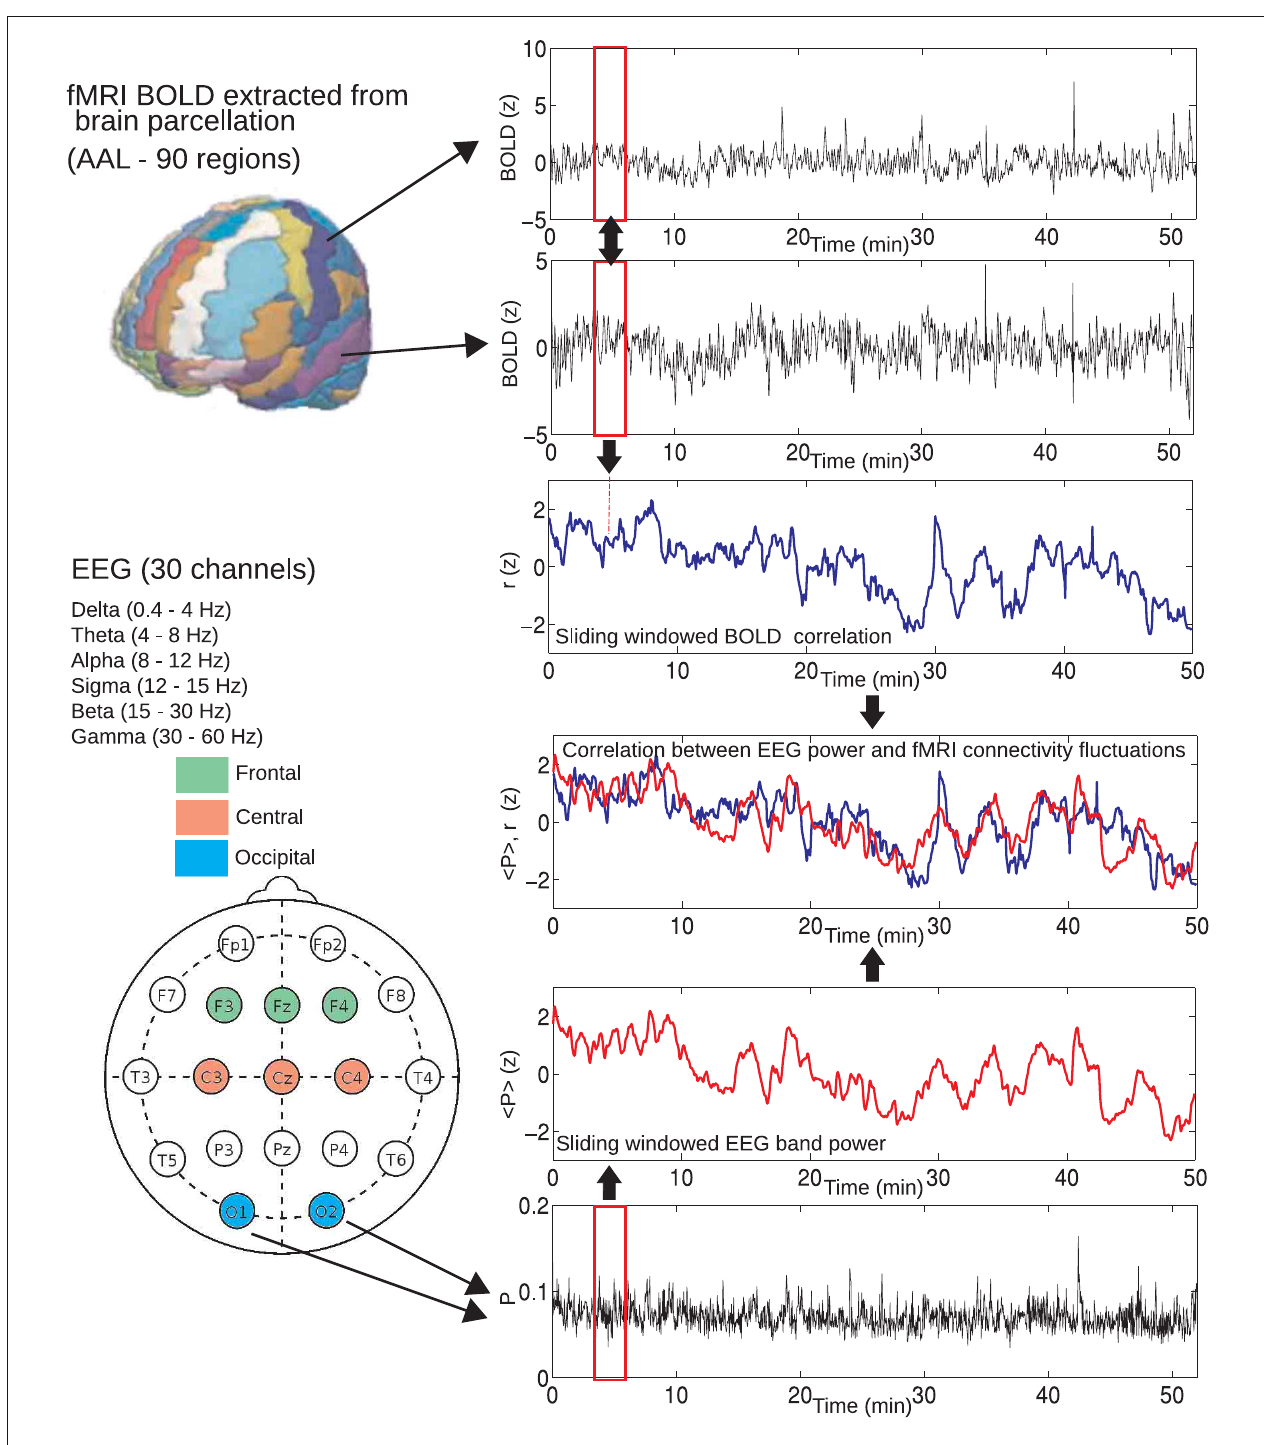
FIGURE 1 | Method used to compute BOLD connectivity fluctuations and correlations with EEG power fluctuations. For each pair of regions, average BOLD signals were extracted and correlated using a sliding window of 60 volumes ( ≈ 2min). This resulted in a connectivity estimate over time. A similar sliding window approach was used to obtain the average EEG power